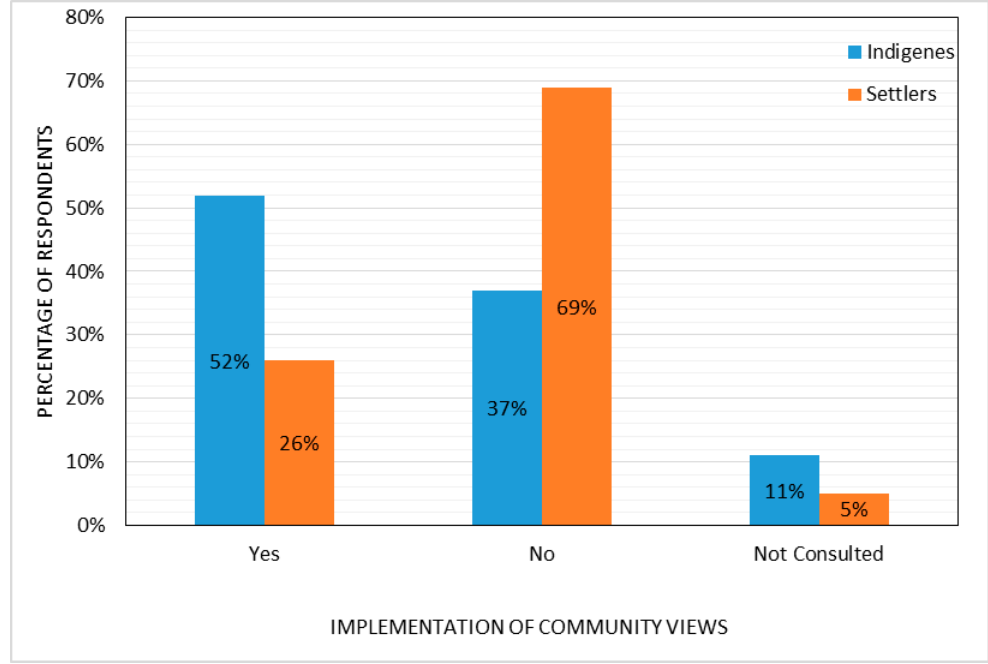
Figure 5. Implementation of community views according to ethnicity (number of indigenes = 19; number of settlers = 19).